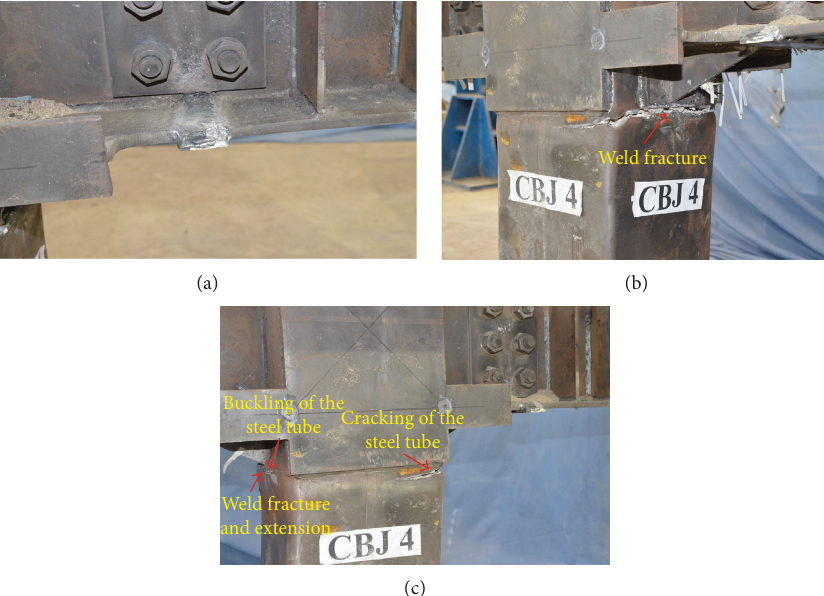
Figure 13: Failure modes of CBJ4: (a) the right beam; (b) weld fracture at the steel tube; (c) buckling of the steel